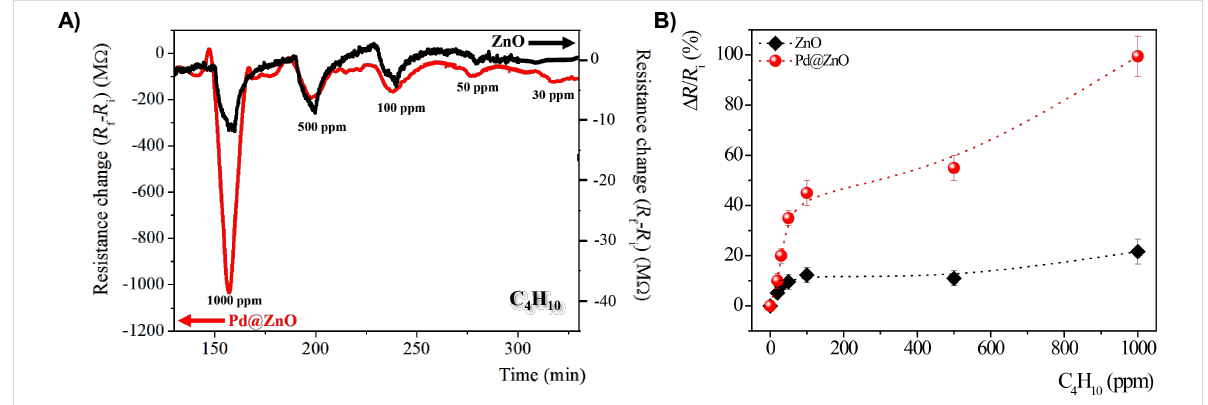
Figure 4: A) Time response and B) calibration curves of the change of electrical resistance of chemiresistors based on pristine and Pd-modified ZnO NRs, exposed to different concentrations (30–1000 ppm) of butane (C 4 H 10 ) at an operating temperature of 300